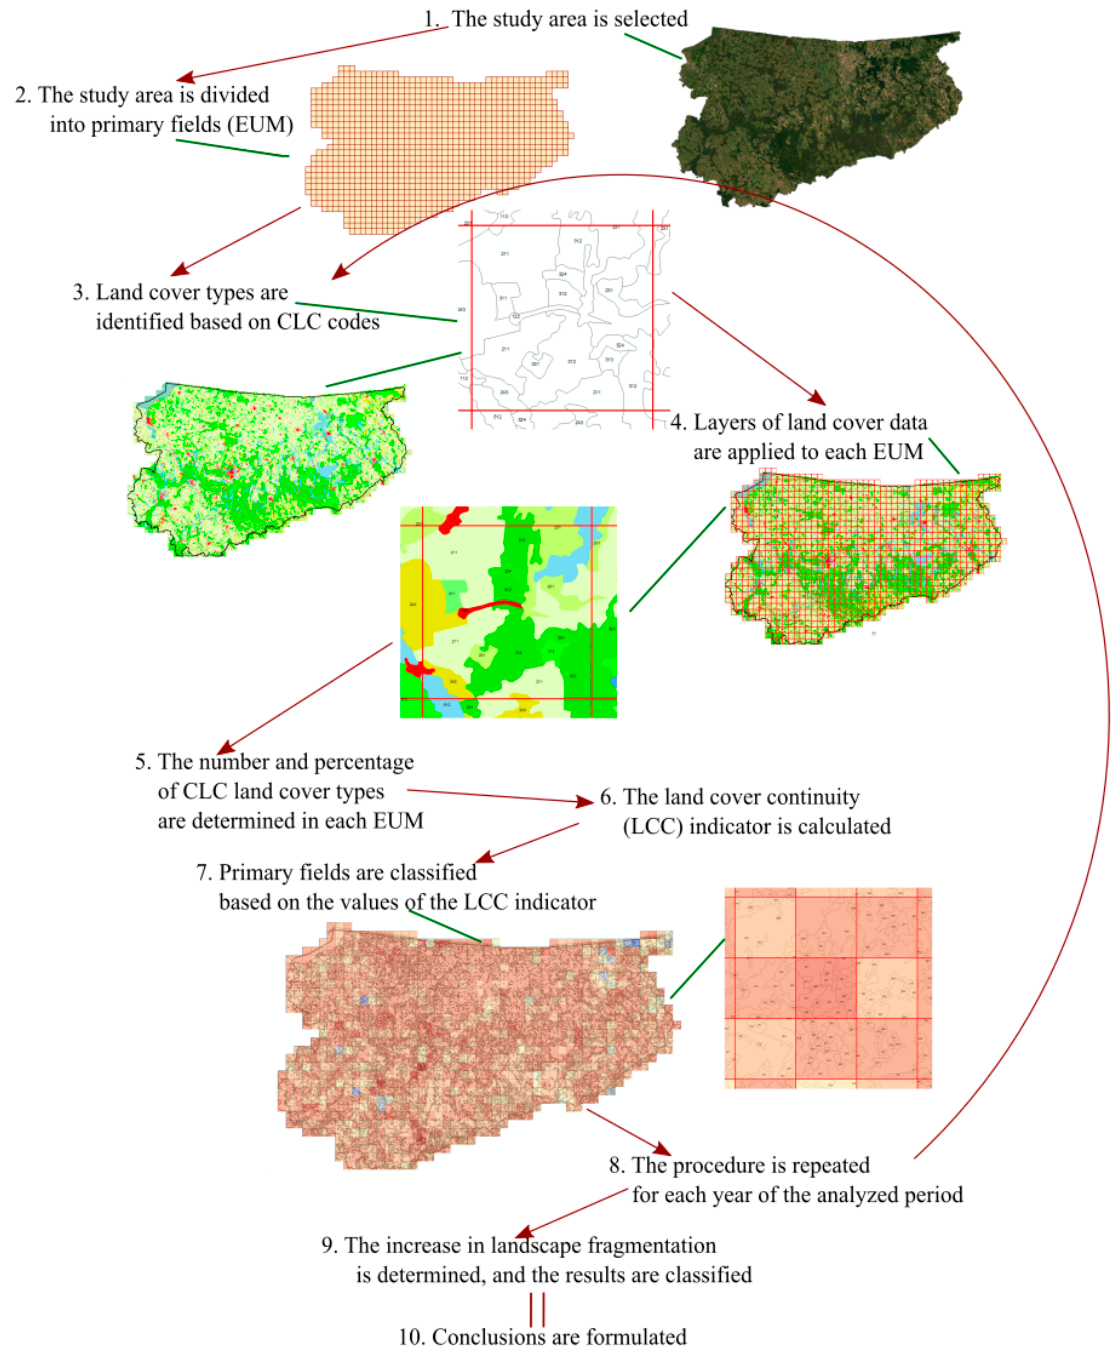
Figure 3. Procedure of using the Coordination of Information on the Environment (CORINE) Land Cover (CLC) data to analyze changes in land cover.